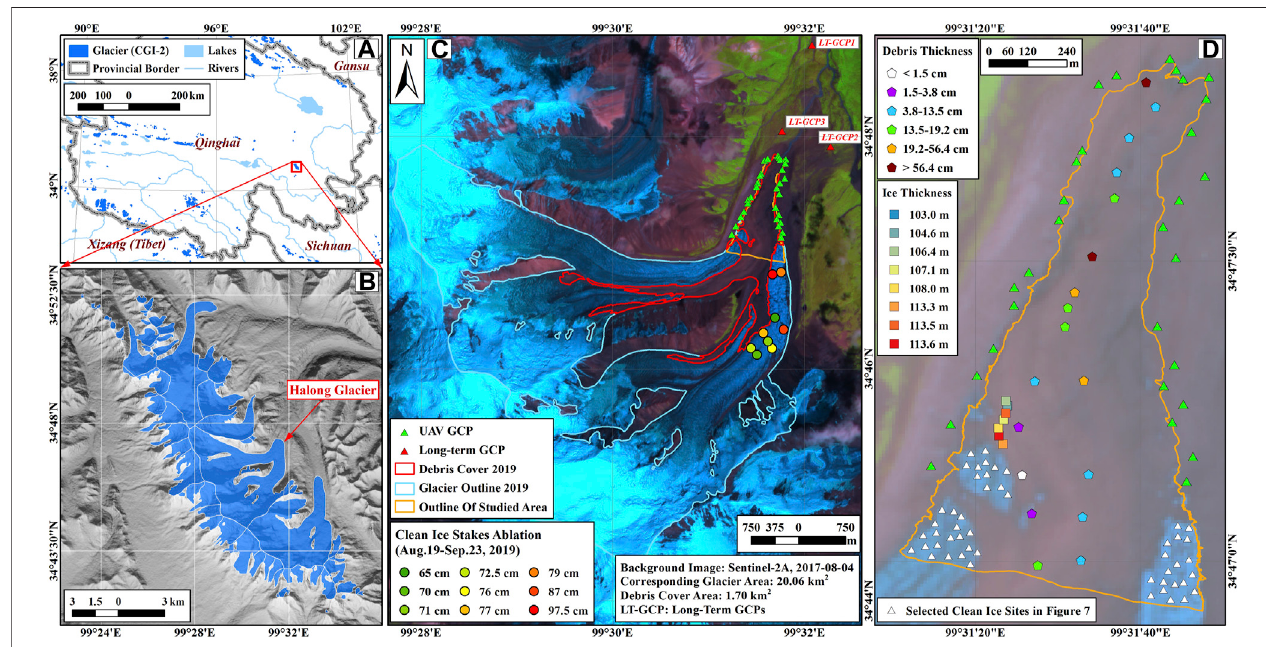
FIGURE1| LocationofHalongGlacier (A,B) ,distributionofUAVGCPsand ablationsofinstalled stakesincleaniceregion (C) ,and distribution ofmeasured debris (on May 24, 2019) and ice (on October 2, 2016; only at selected sites) thickness (D) .